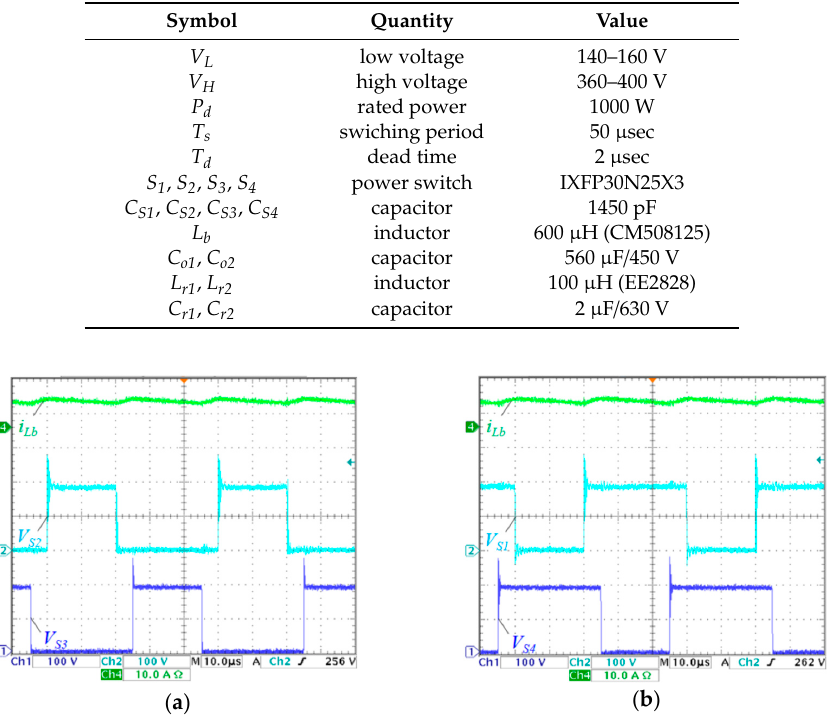
Figure 8. The experimental waveforms of the conventional converter in the step-up mode: ( a ) i Lb , V S2